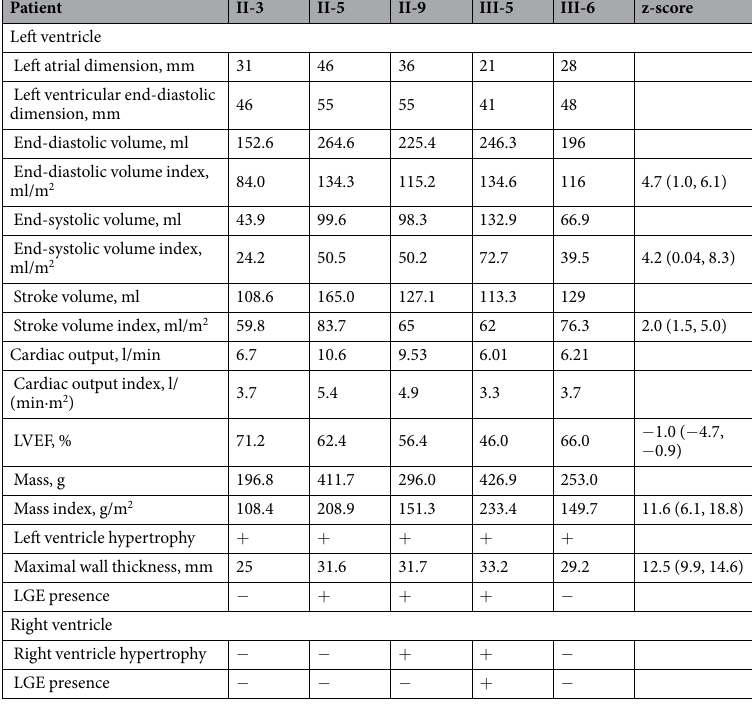
III-5, who had the most markedly increased LV mass, had hypertrophy predominantly in the mid-lateral seg- ments with a maximal wall thickness of 33.2 mm (z-score, 13.47) (Fig. 5D). The right ventricle was also involved with a maximal wall thickness of 13.9 mm located in the mid-anterior segment. Prominent trabeculae were observed in the mid-distal part of the lateral wall of patient III-6 (see Supplementary Fig. S1), whose maximal wall thickness was located in the mid-inferolateral segment (Fig. 5E). LGE was present in three of the five patients (60%) examined by CMR (Fig. 3 and Supplementary Fig. S1). Hyperenhancement primarily focused on the mid-distal hypertrophic regions, and all three LGE positive patients presented with a subendocardial pattern. Transmural hyperenhancement within the apical regions was also